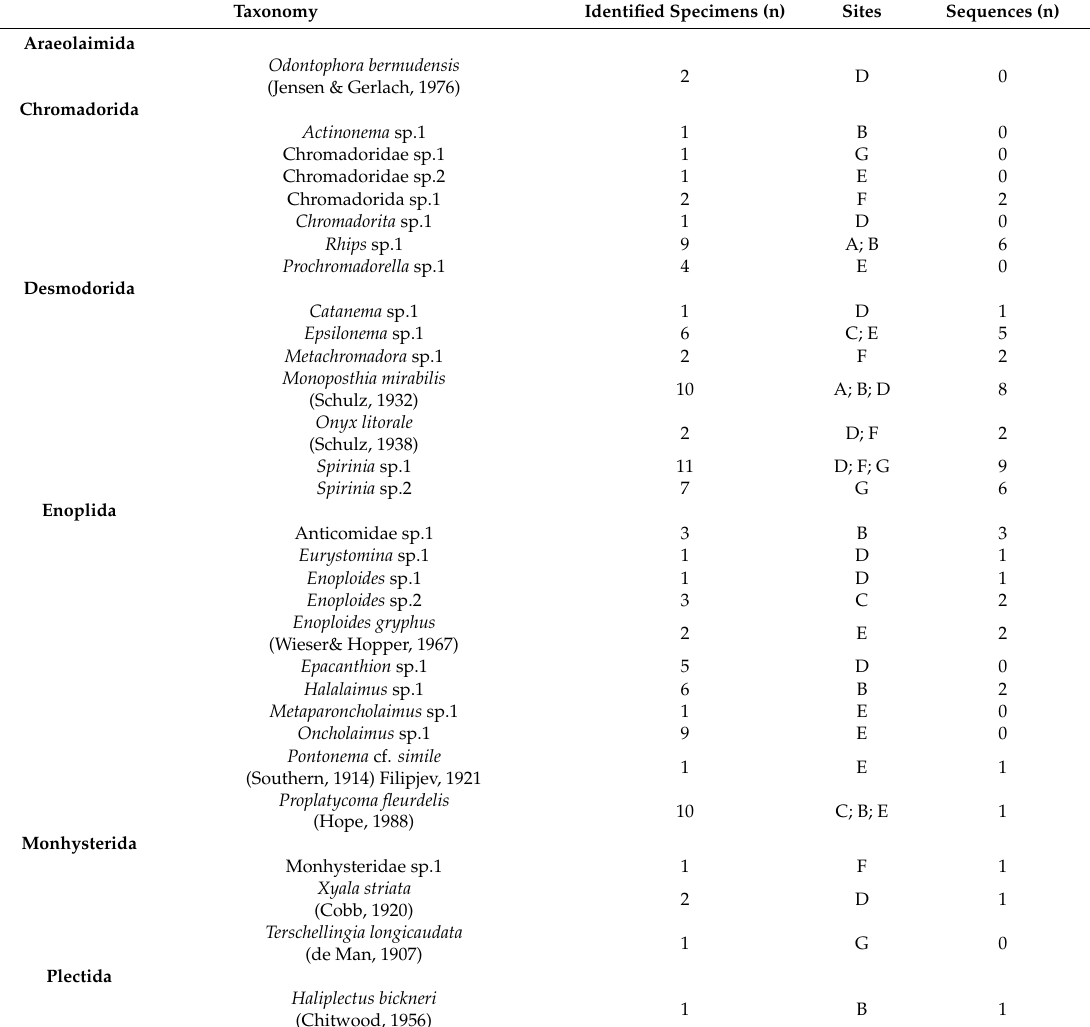
Table 2. Morphotypes identified at the collection sites. Species are listed by nematode Order. The number of individuals and COI sequences analyzed in this study are indicated. Taxonomy classification is based on Nemys database (www.marinespecies.org) [12]. Sites are indicated as below: Canc ú n = A; Puerto Morelos = B; Cozumel, Playa Azul = C; Cozumel, Punta Sur = D; Tulum = E; Mahahual = F; and Xcalak =